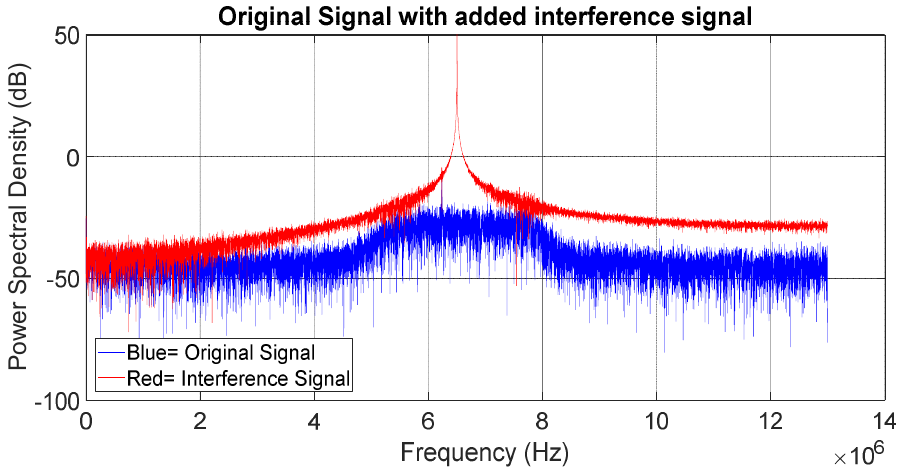
Figure 15. Frequency power spectrum of the raw sampled RF front-end data with added CW interference at J/No = 80 dB-Hz and freqj = 6.5033 MHz .